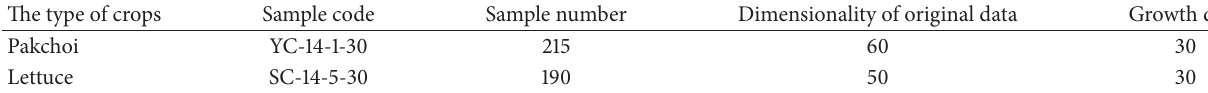
Table 2: The description of test data.